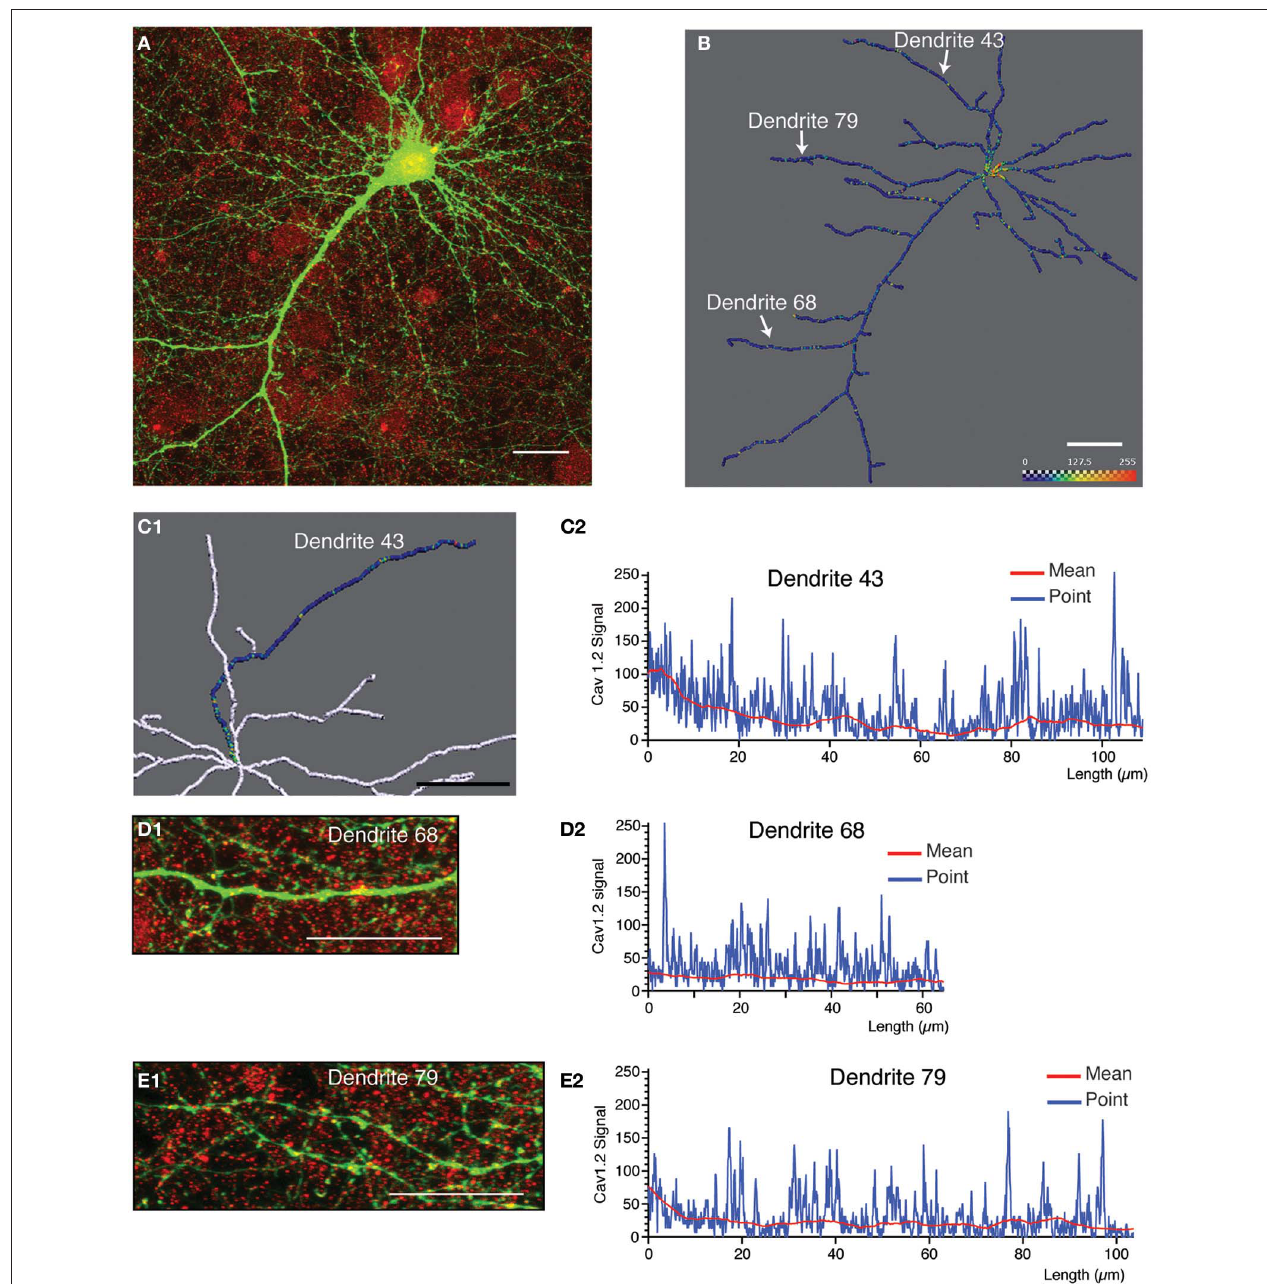
FIGURE 5 | Quantitative analysis and 3D profiling of endogenous Cav1.2 signal in cultured neocortical neurons. (A) Image stack corresponding to endogenous Cav1.2 signal (red) overlaid with neuronal morphology (labeled by eGFP expression, green). Image is a z-projection derived from maximum signal intensity across 65 focal planes. (B) Amira image showing reconstructed dendritic skeleton (represented as a filament) overlaid with 3D ion channel profile derived from point fluorescence values calculated along the dendrite skeleton. The color map has been adjusted to best represent, on a graphical level, the predominant ion channel clusters. (C1) Magnification of a section of the reconstructed skeleton showing the ion channel profile of a selected dendrite (dendrite 43). Image has been flipped (reflected along vertical axis) to better correspond